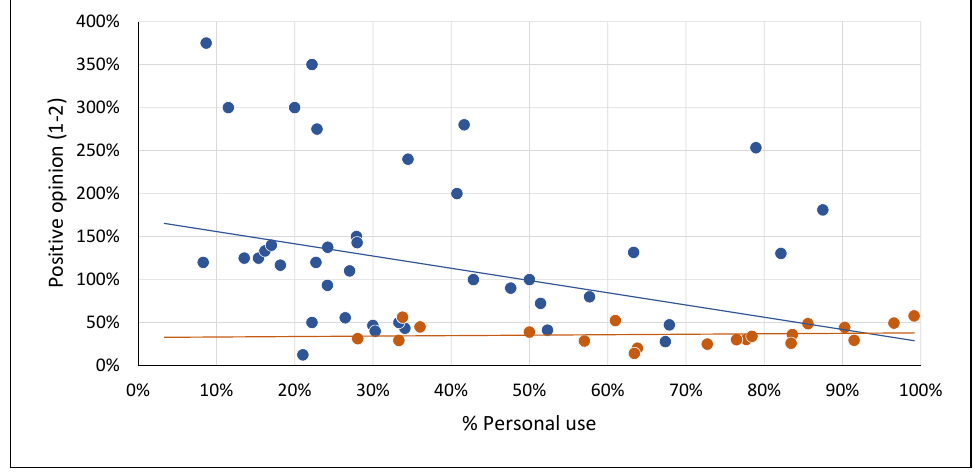
Figure 4. Positive opinion (1–2) on communication from insurer on social media by personal use (blue all social media; red WhatsApp, Facebook, Instagram, and YouTube only).